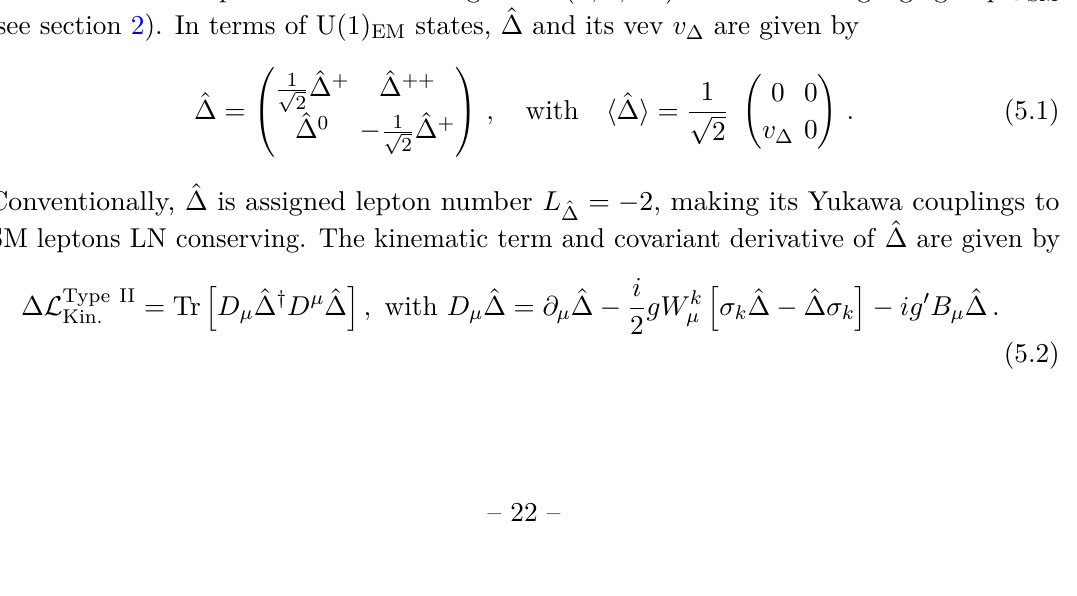
Figure 4 . (a) Same as figure 3(a) but for of doubly (∆ ±± ) and singly (∆ ± ) charged scalars in the Type II Seesaw; figure adapted from ref.